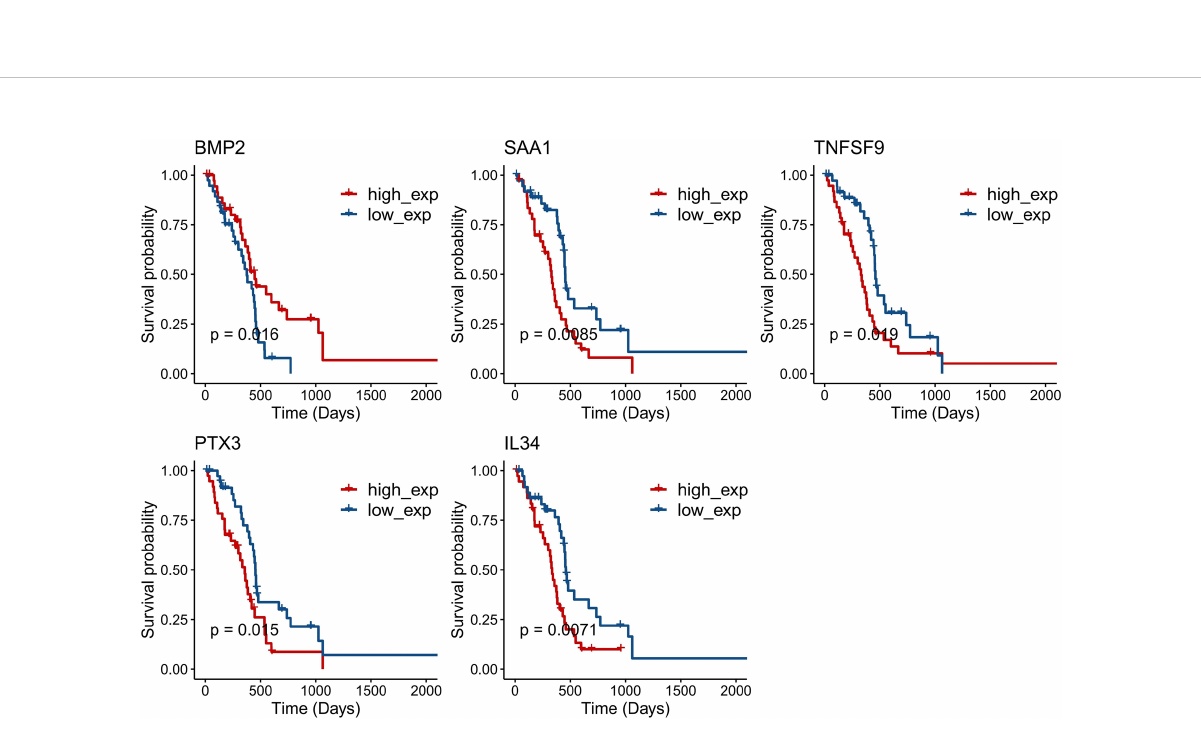
FIGURE 3 Kaplan – Meier survival curves of fi ve single genes ( P < 0.05): IL34 ( P = 0.0071), SAA1 ( P = 0.0085), PTX3 ( P = 0.015), BMP2 ( P = 0.016), and TNFSF9 ( P =